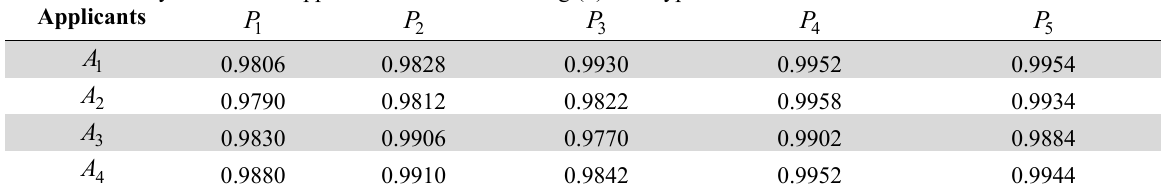
Cosine Similarity measure of Applicants vs. Positions using (9) and Type-1 score function